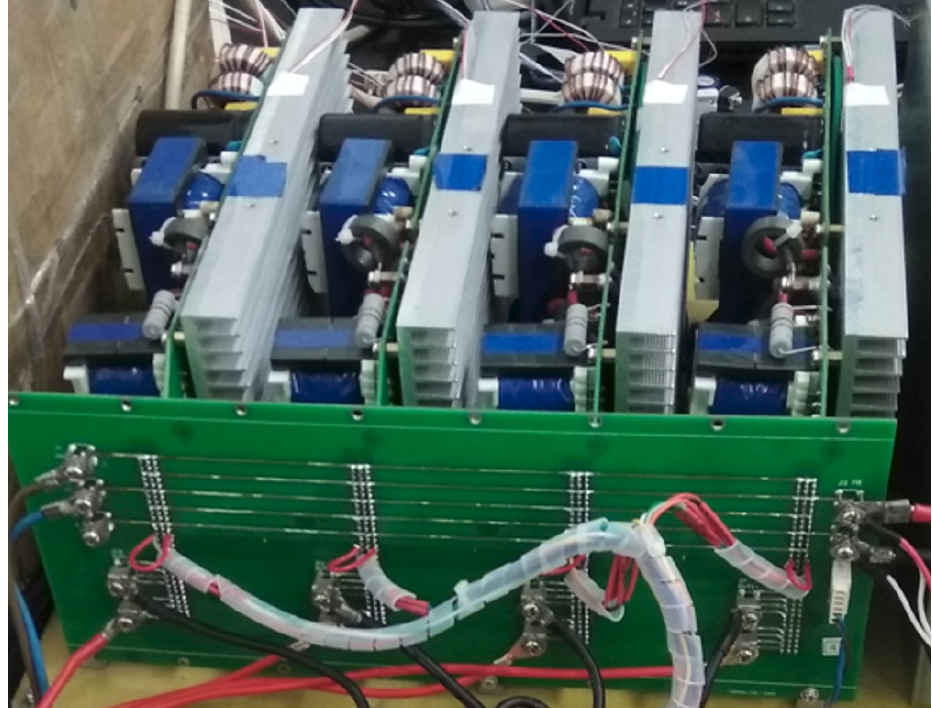
Figure 18. Photo of the 3 + 1 parallel redundant power